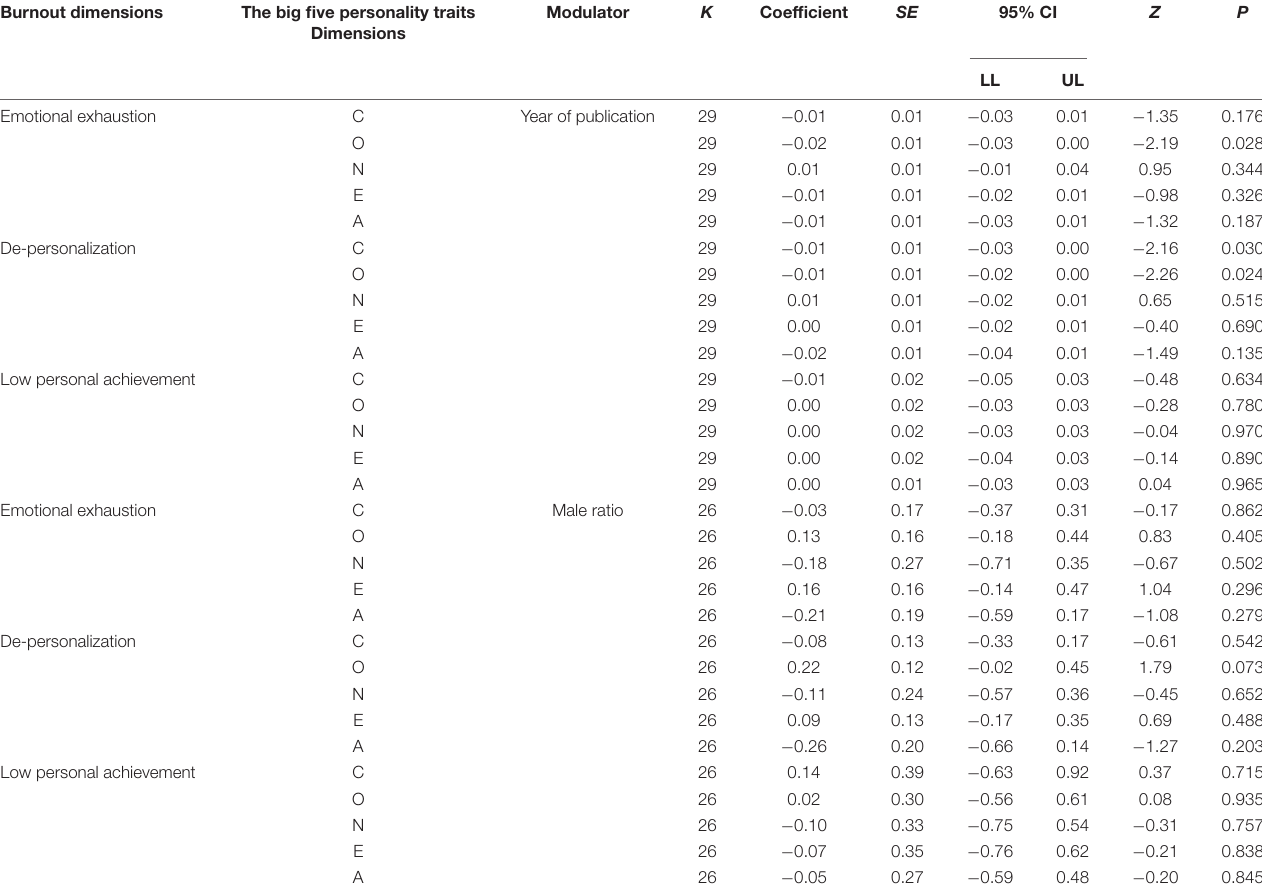
TABLE 9 | Meta-regression analysis of the moderating effects of publication age and male proportion on the relationship between each dimension of big five personality traits and each dimension of job burnout. Burnout dimensions The big five personality traits